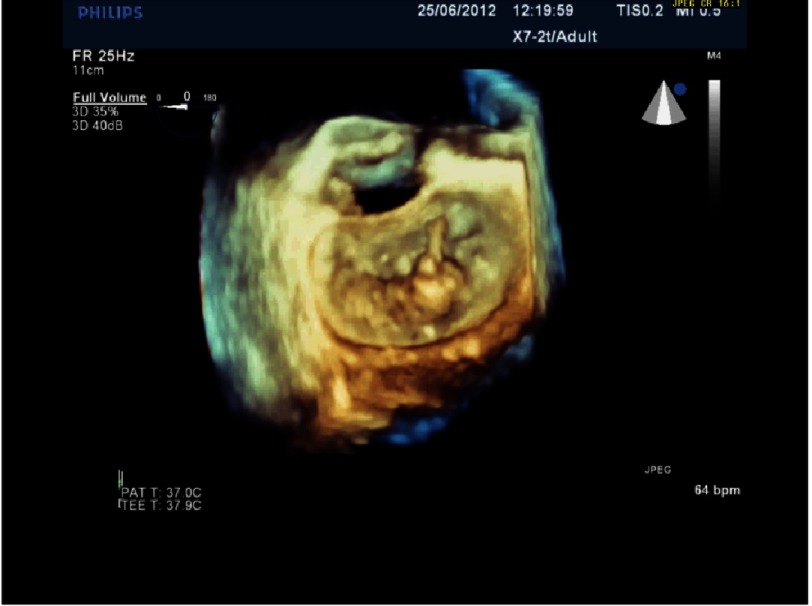
Same patient as Figure 14.